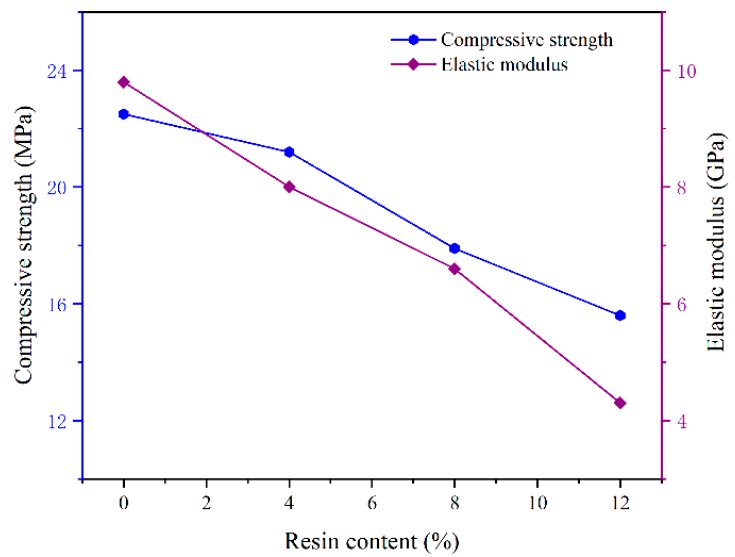
Figure 3. Mechanical properties versus resin content.